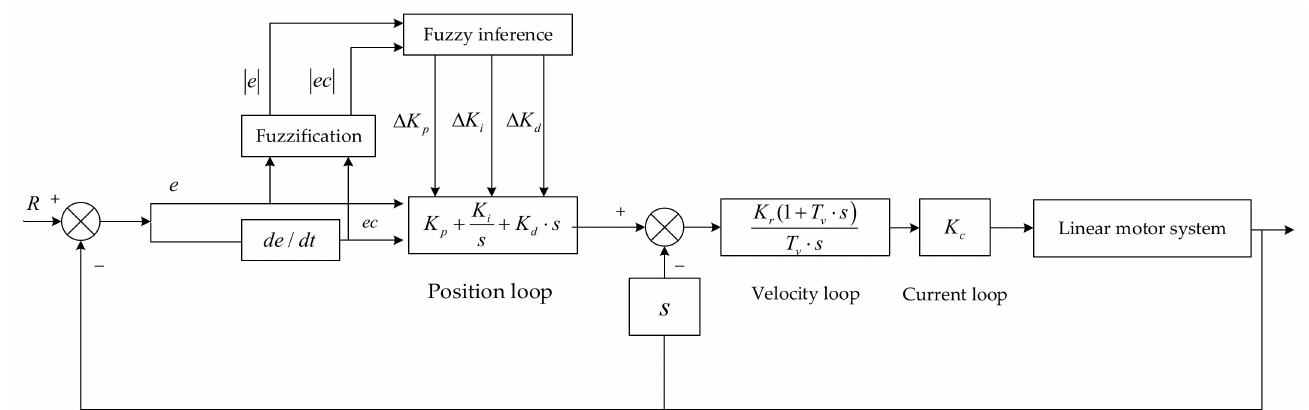
Figure 8. Control model of fuzzy PID position controller for linear motor.